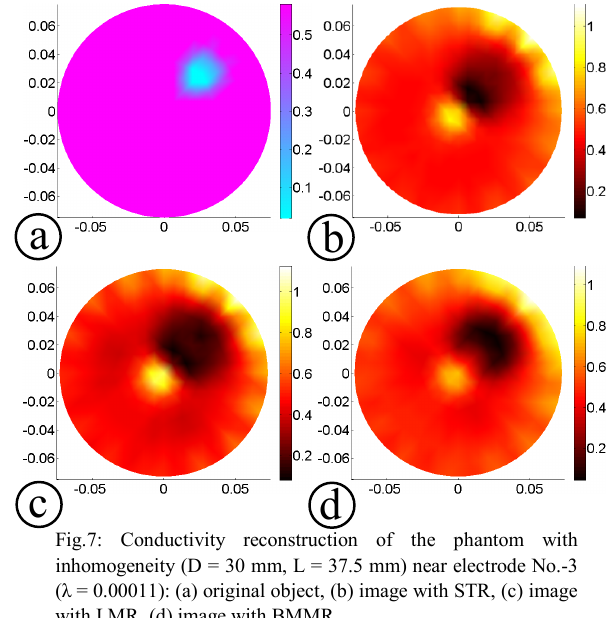
Fig.6: Conductivity reco nstruction of the phantom with inhomogeneity (D = 30 mm, L = 37.5 mm) near electrode No.-3 (λ = 0.0001): (a) original object, (b) image with STR, (c) image with LMR, (d) image with BMMR. Table-2: CNR, PCR and COC of the conductivity images of Fig. -6 λ = 0.0001